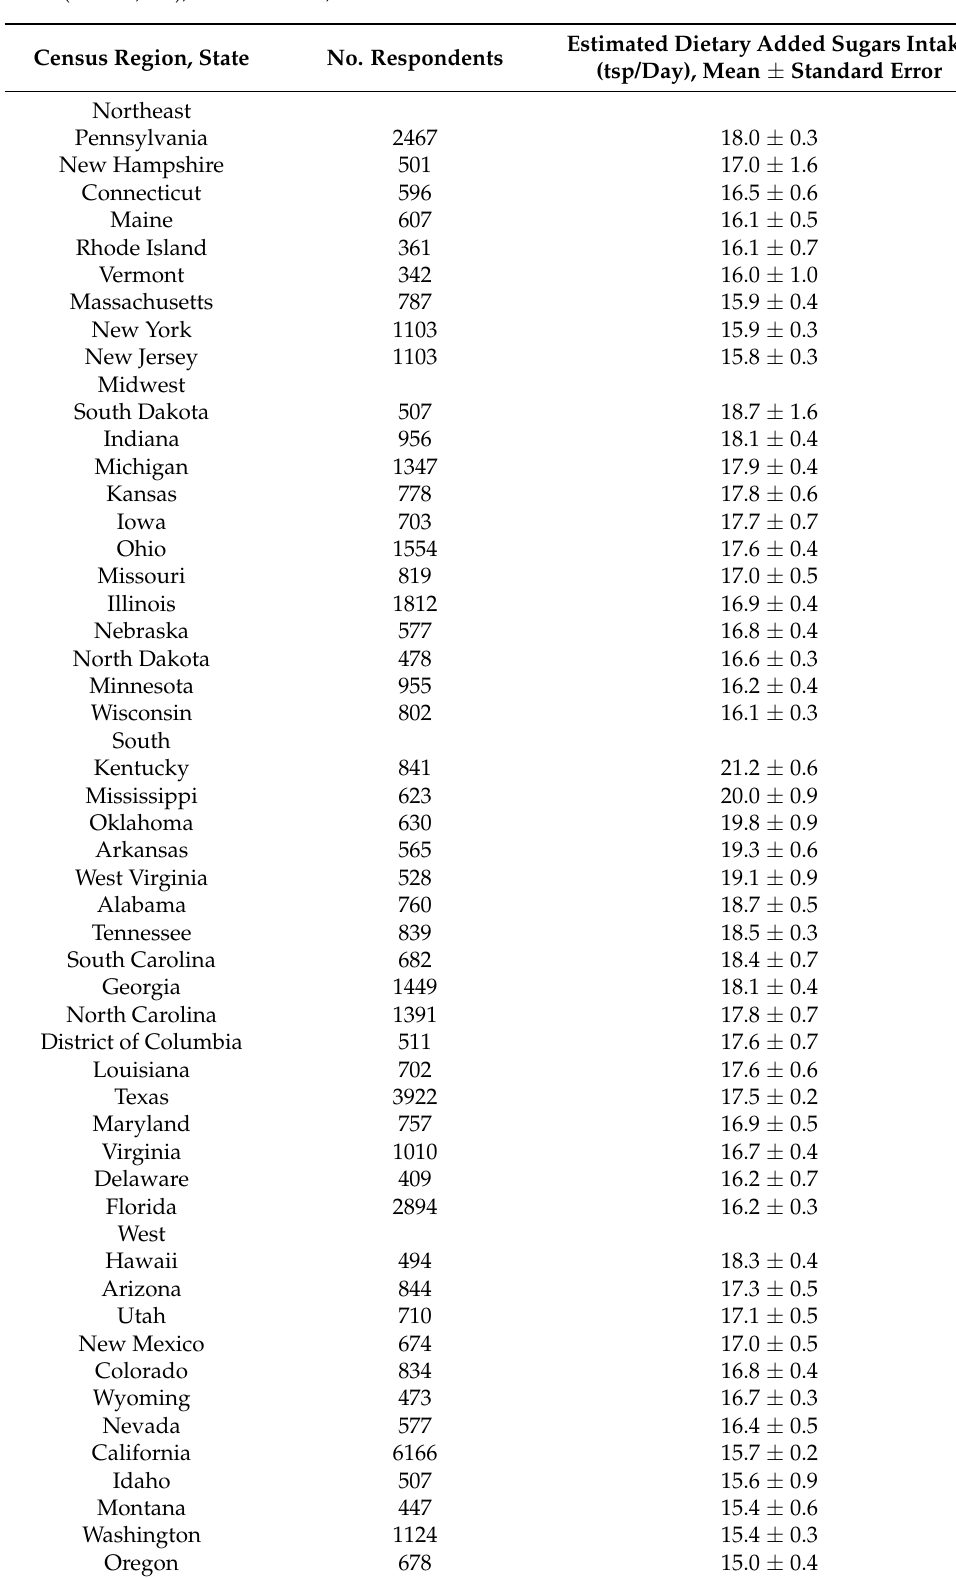
Table 2. Estimated mean dietary-added sugars intake (teaspoon/day) among US adults aged 18 or older (N = 52,279), United States, 2010 and 2015 a